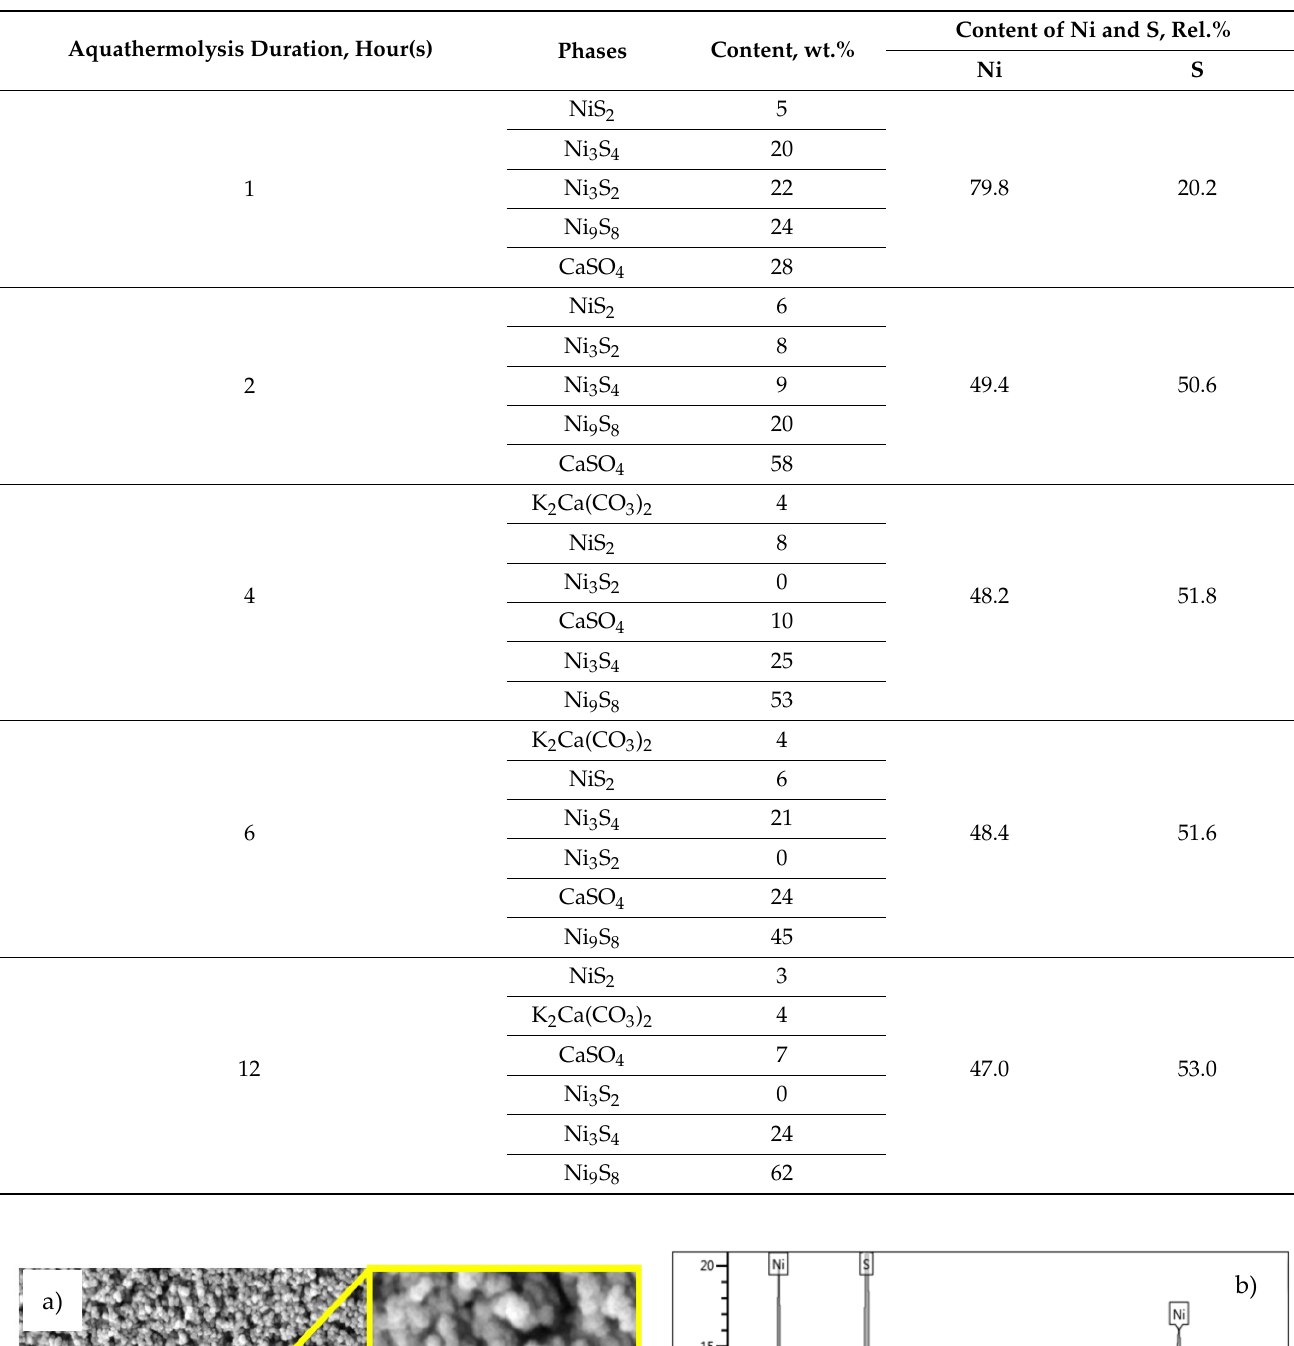
Table 1. The phases and contents of nickel-based catalyst after hydrothermal exposure. Aquathermolysis Duration, Hour(s)